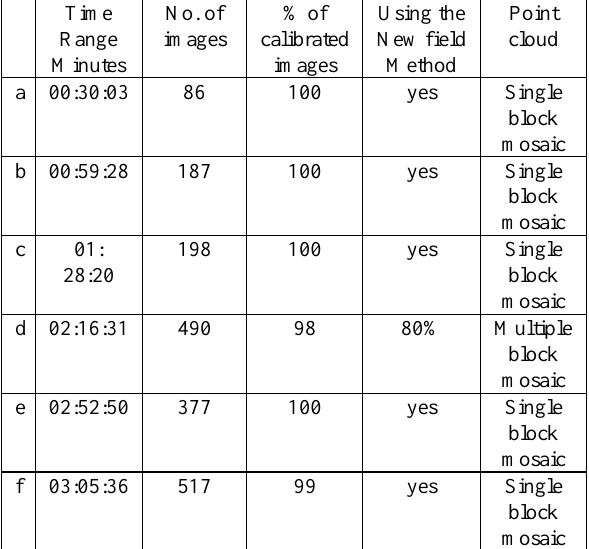
effect of drifting. The dense point cloud from survey d in table 2. is downgraded into multiple block mosaics as shown below.